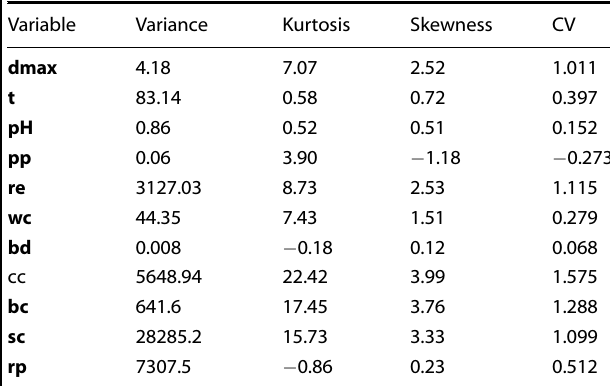
Table 1. Description of the overall distribution of the variables.